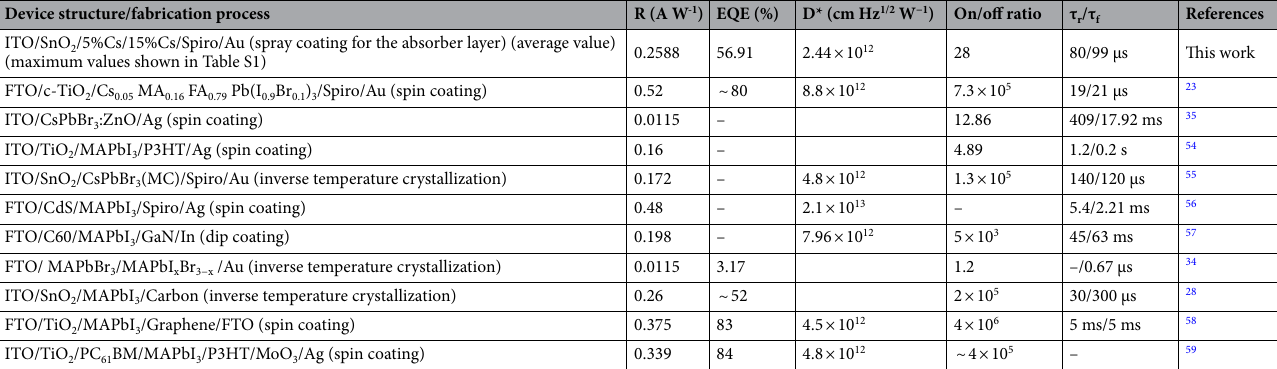
Table 1. Comparison of PPD parameters of different self-powered PPDs.